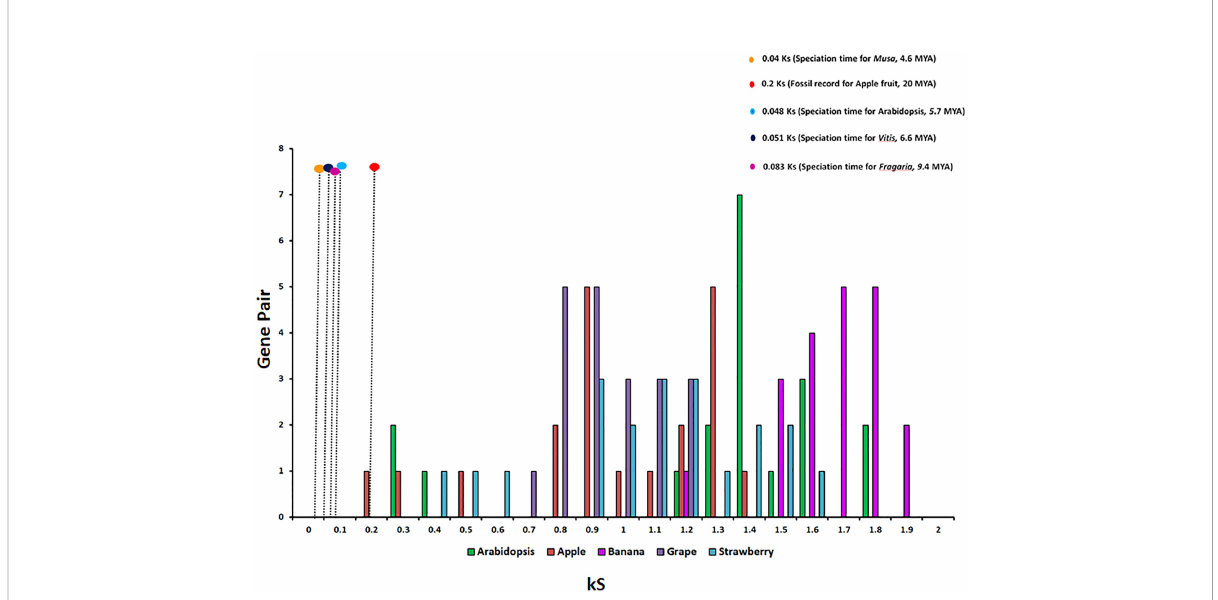
FIGURE 3 The relative substitution plot of kS score of gene pairs of fruit carbamoyltransferase genes, representing the synonymous substitution sites with speciation time of different fruits and Arabidopsis . The speciation time has been taken from timetree.org.